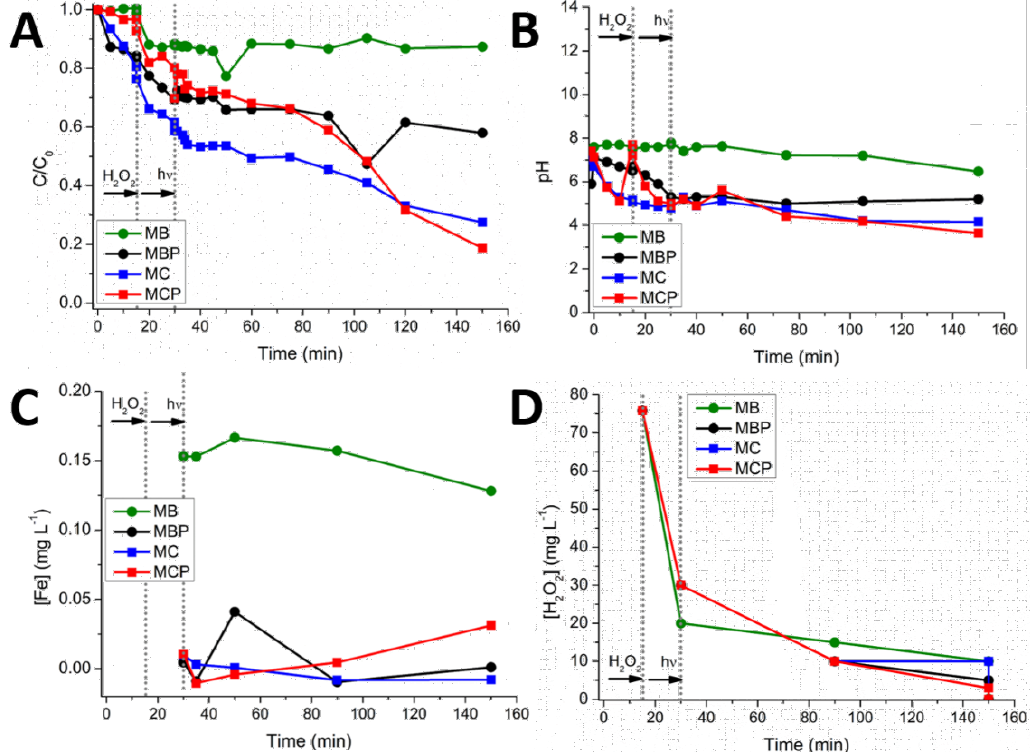
Figure 6. Evolution of the DCF concentration (C 0 = 20 mg L − 1 ) ( A ), pH ( B ), [Fe] ( C ), [H 2 O 2 ] ( D ), during the experiments against the four different materials. Data reported consider a final concentration of materials of 500 mg L − 1 and final time of 150 min. Legend: MB green circles, MBP black circles, MC blue squares, MCP red squares.